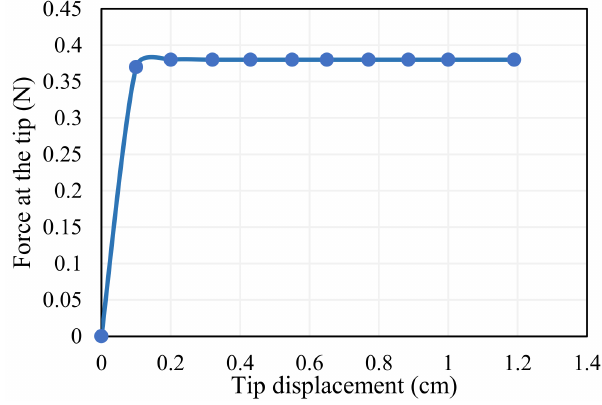
Figure 4. Strain energy due to input